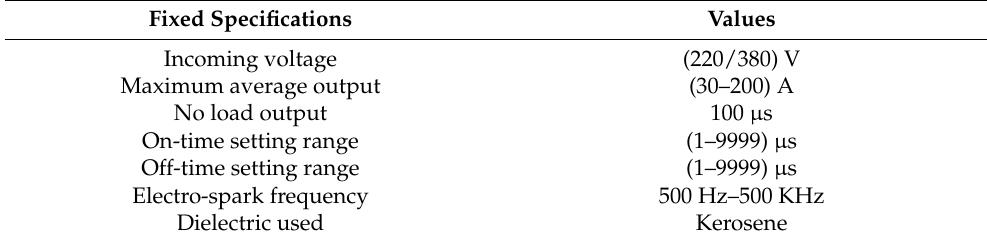
Table 1. Specifications of EDM die sinker.